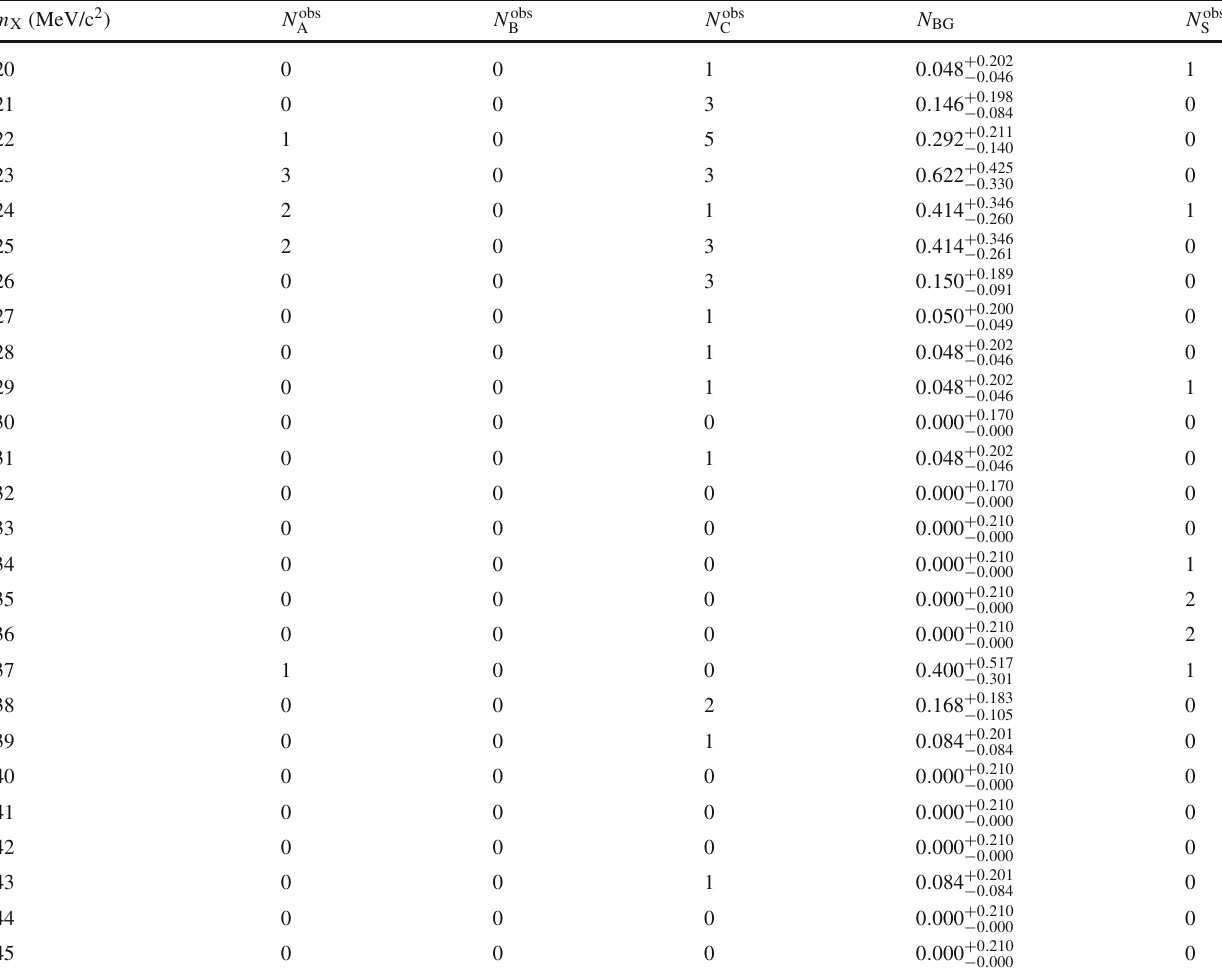
Table 2 The number of observed events in the sideband regions and the signal region and the expected number of background events in the signal region m X (MeV/c 2